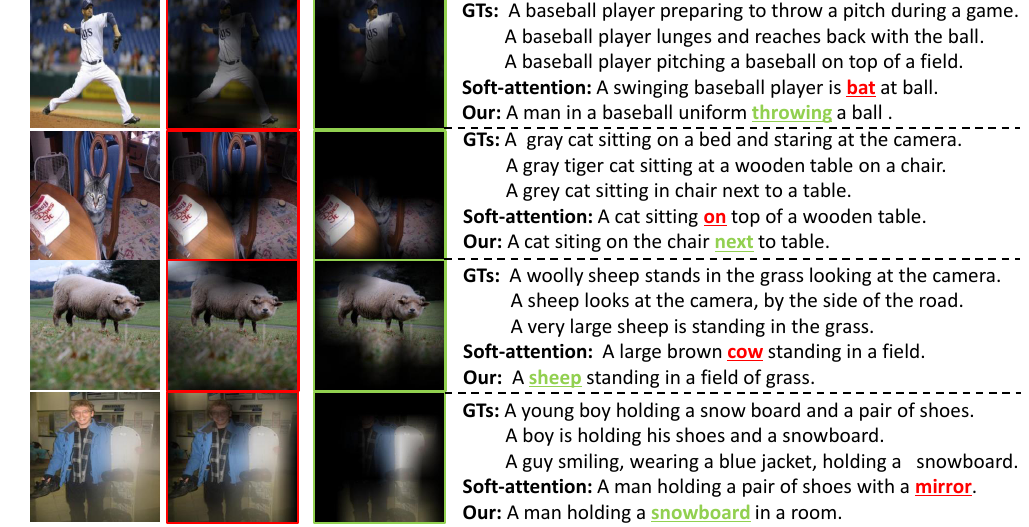
Figure 4. Qualitative results for our method performance. From left to right: original image, soft-attention map (red), our attention map (green) corresponding the underline